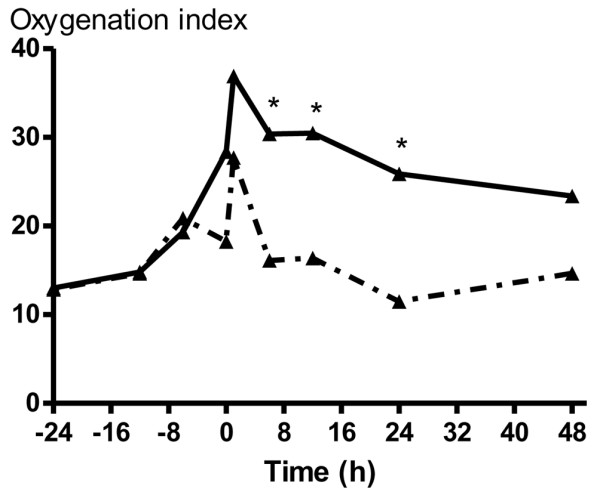
The oxygenation index (OI) was higher in the nonsurvivors (solid line) compared with the survivors (dash line) in the diffuse alveolar disease group before the start of high-frequency oscillatory ventilation (HFOV). The OI became significant after the start of HFOV. * P < 0.05.